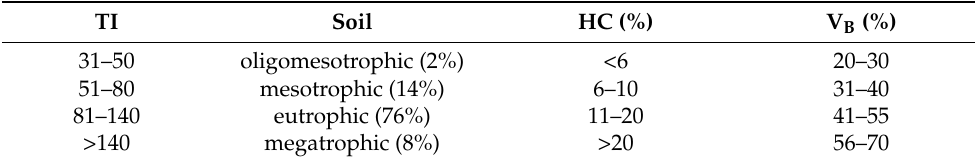
Table 2. Soil classification based on TI values.